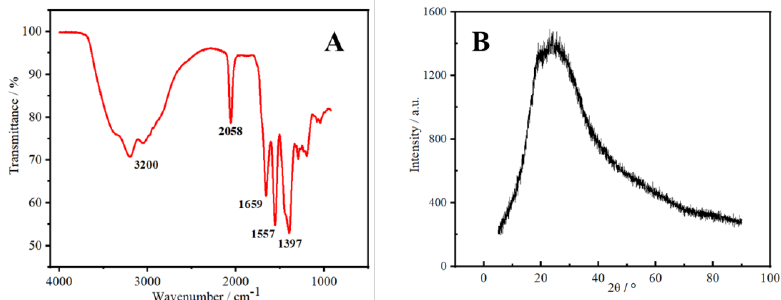
Figure 3. FT − IR spectrum ( A ) and XRD pattern of the synthesized N-CDs ( B ).